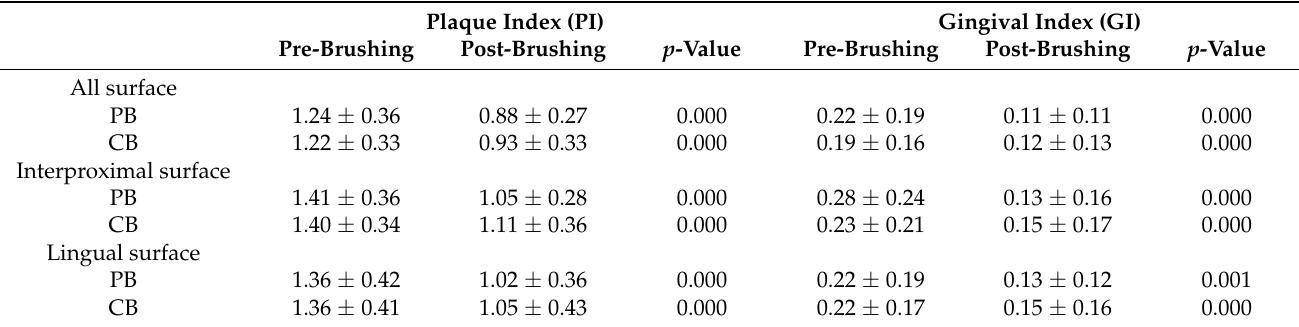
Table 2. Comparison of plaque index and gingival index before and after brushing: mean score (standard deviation) for all, interproximal, and lingual